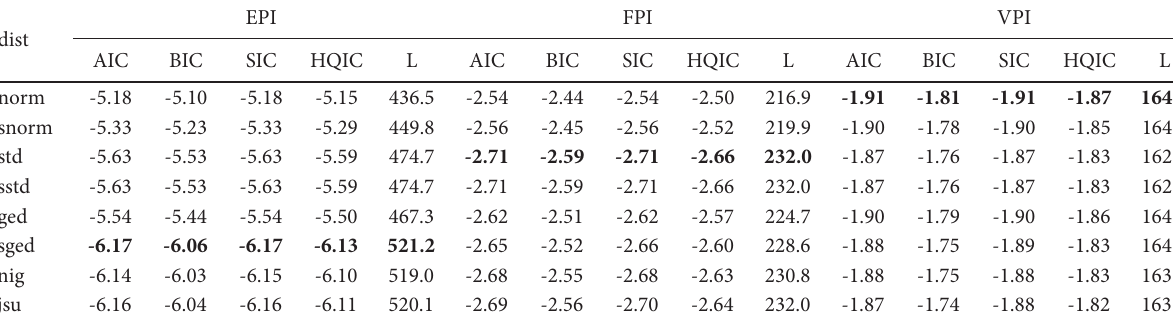
Table 2. EGARCH(1,1) Model Evaluation depending on Information Criteria and Likelihood Values. EPI FPI